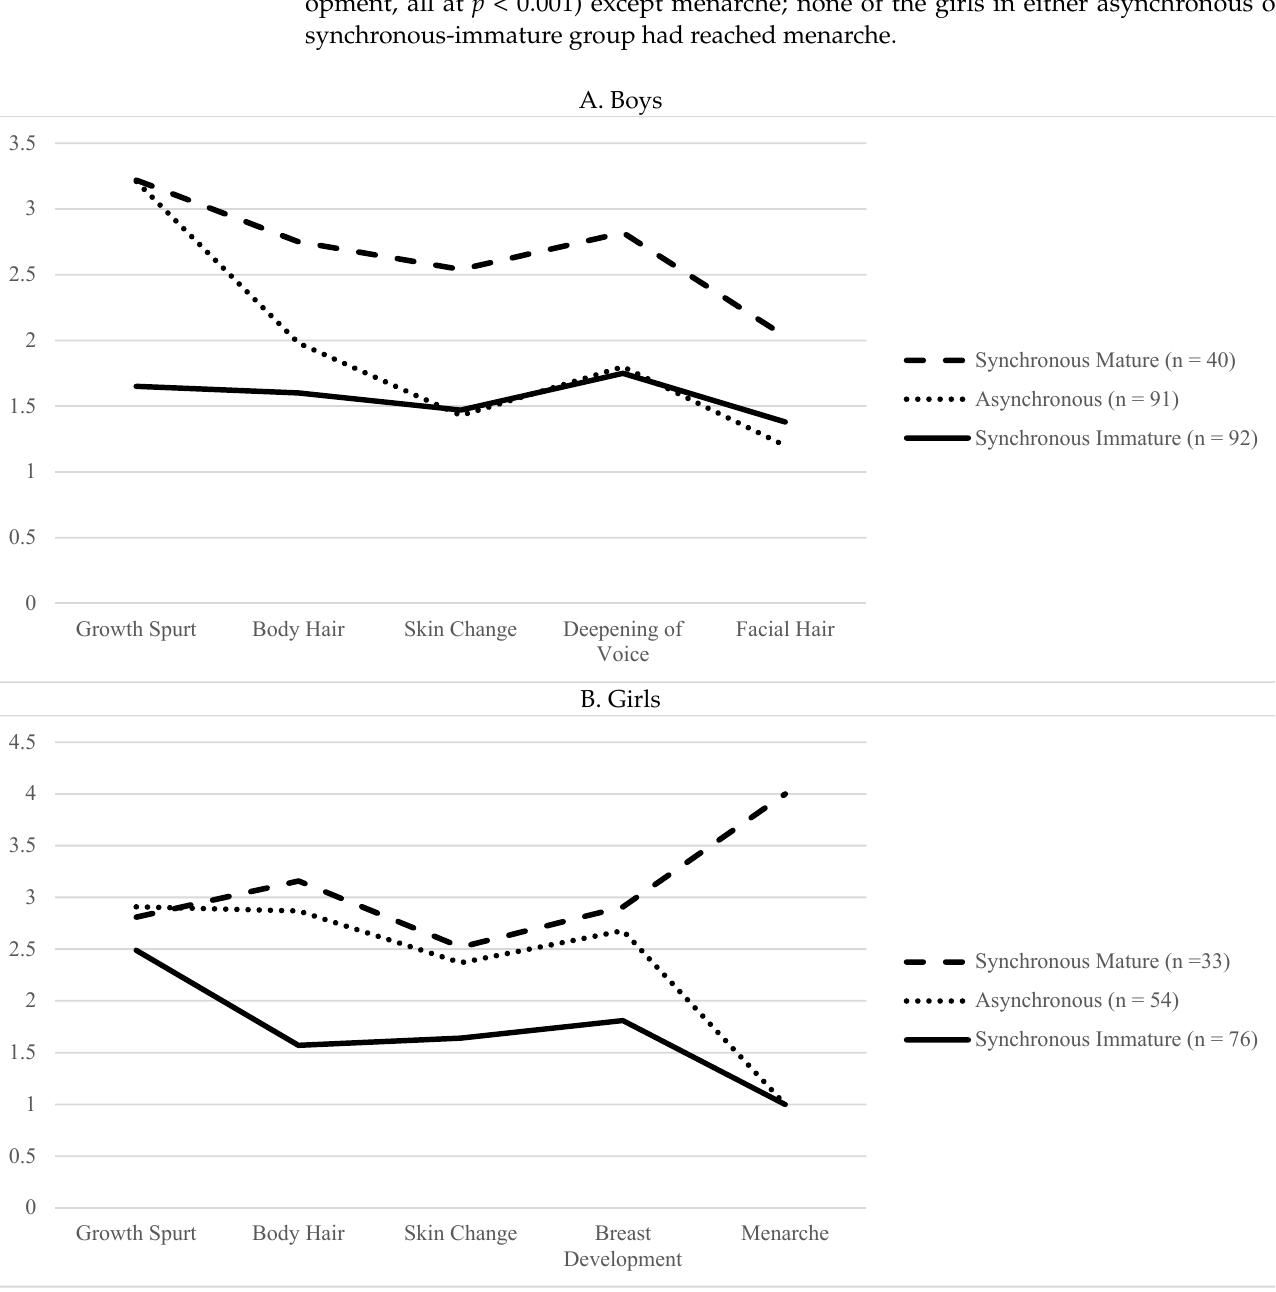
Figure 2. Average maturation levels by puberty-related body changes for boys and girls. Boys . As expected, there were significant differences in the levels of growth based on boys’ cluster membership, F (10, 416) = 81.32, p < 0.001, Wilk’s Λ = 0.11, partial η 2 = 0.66.